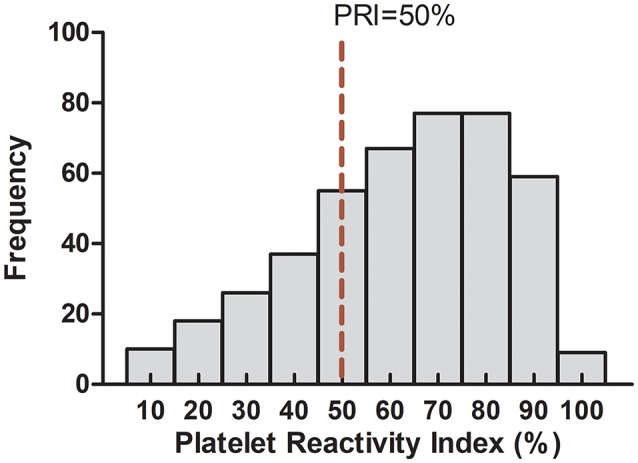
Detailed frequency distribution of the study subjects in relation to platelet reactivity index.